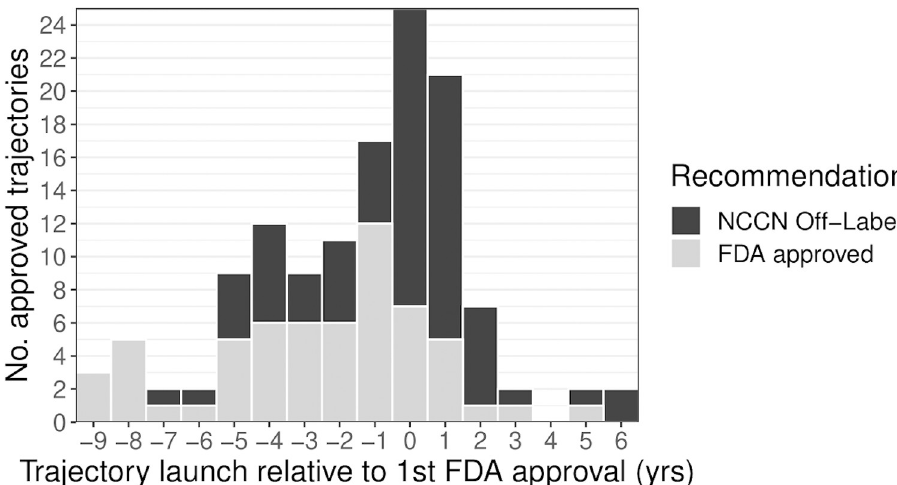
Fig 1. Trajectory launch date relative to FDA approval for secondary approvals and off-label recommendations. The date trajectory launch for each drug-indication pairing was graphed in comparison to the first FDA approval, which is represented by 0 on the x-axis. The light grey represents the beginning of trajectories that lead to secondary approvals while the dark grey represents the ones that lead to off-label recommendations in NCCN